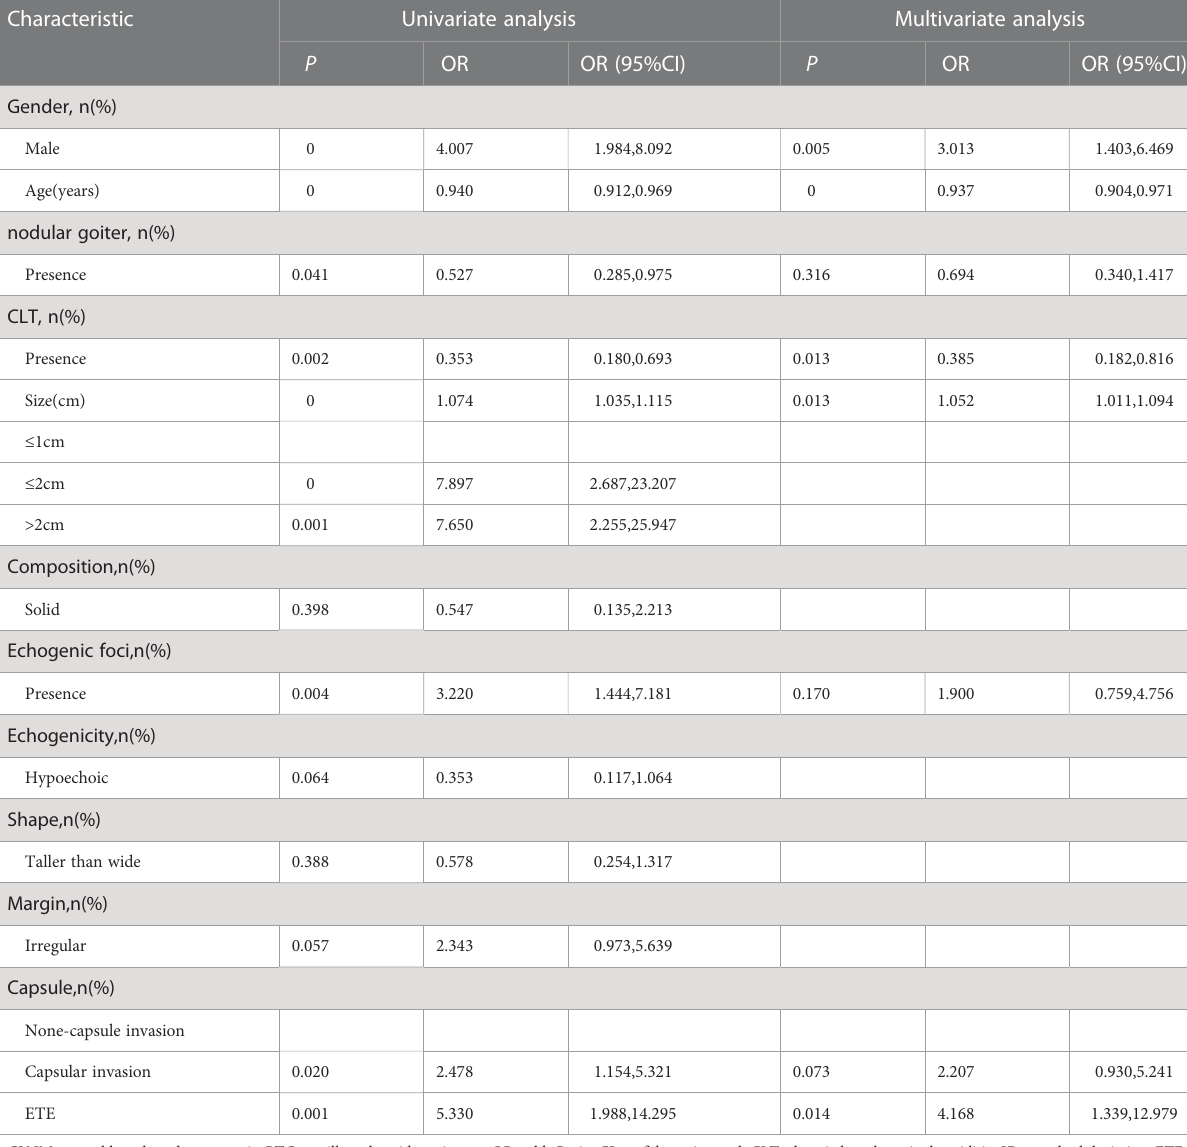
TABLE 5 Univariate analysis and multivariate analysis of factors associated with number of central lymph node metastasis (CLNM) in patients with isthmus papillary thyroid carcinoma (PTC). Characteristic Univariate